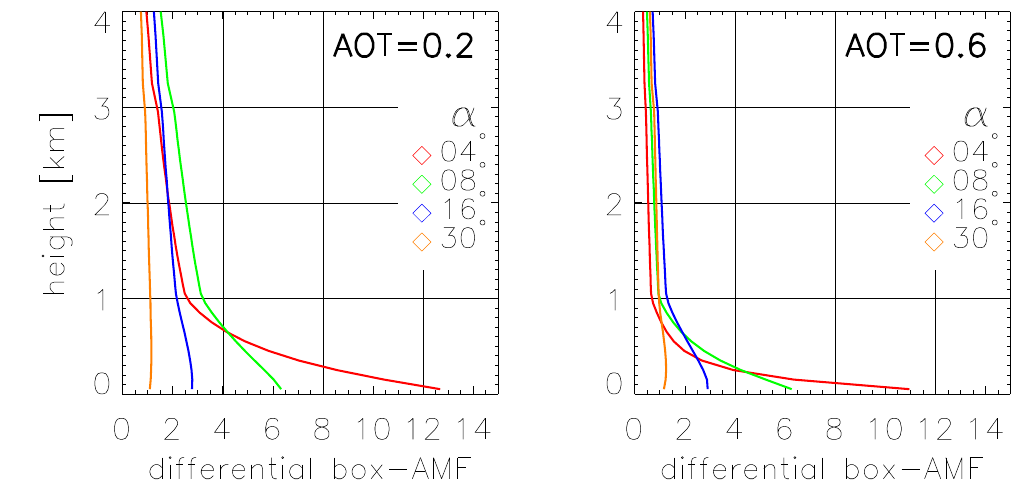
Fig. 8. Radiative transfer simulations with the DAK model of height-dependent differential AMF (differential box-AMF) for AOT=0.2 (left) and AOT=0.6 (right), at 428.22 nm . Settings in the simulations: boundary layer height for aerosols (block profile): 1.0 km , solar zenith angle = 60 ◦ , relative azimuth angle = 180 ◦ , λ =428 nm .